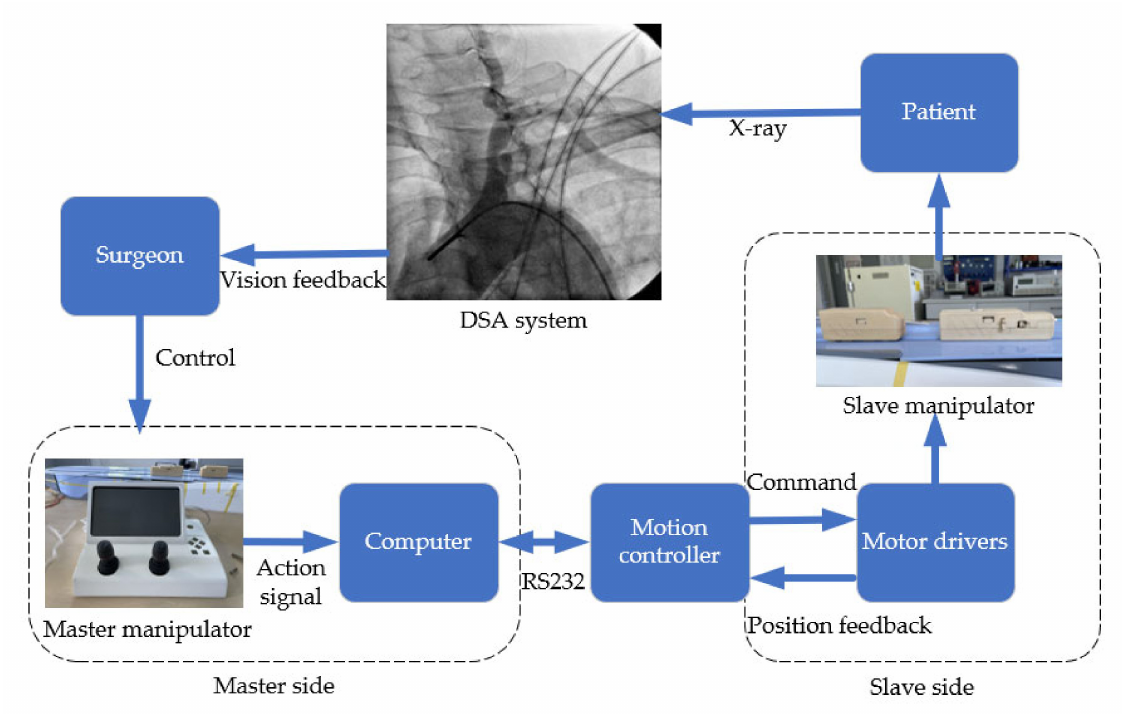
Figure 1. The workflow of the surgical robot.